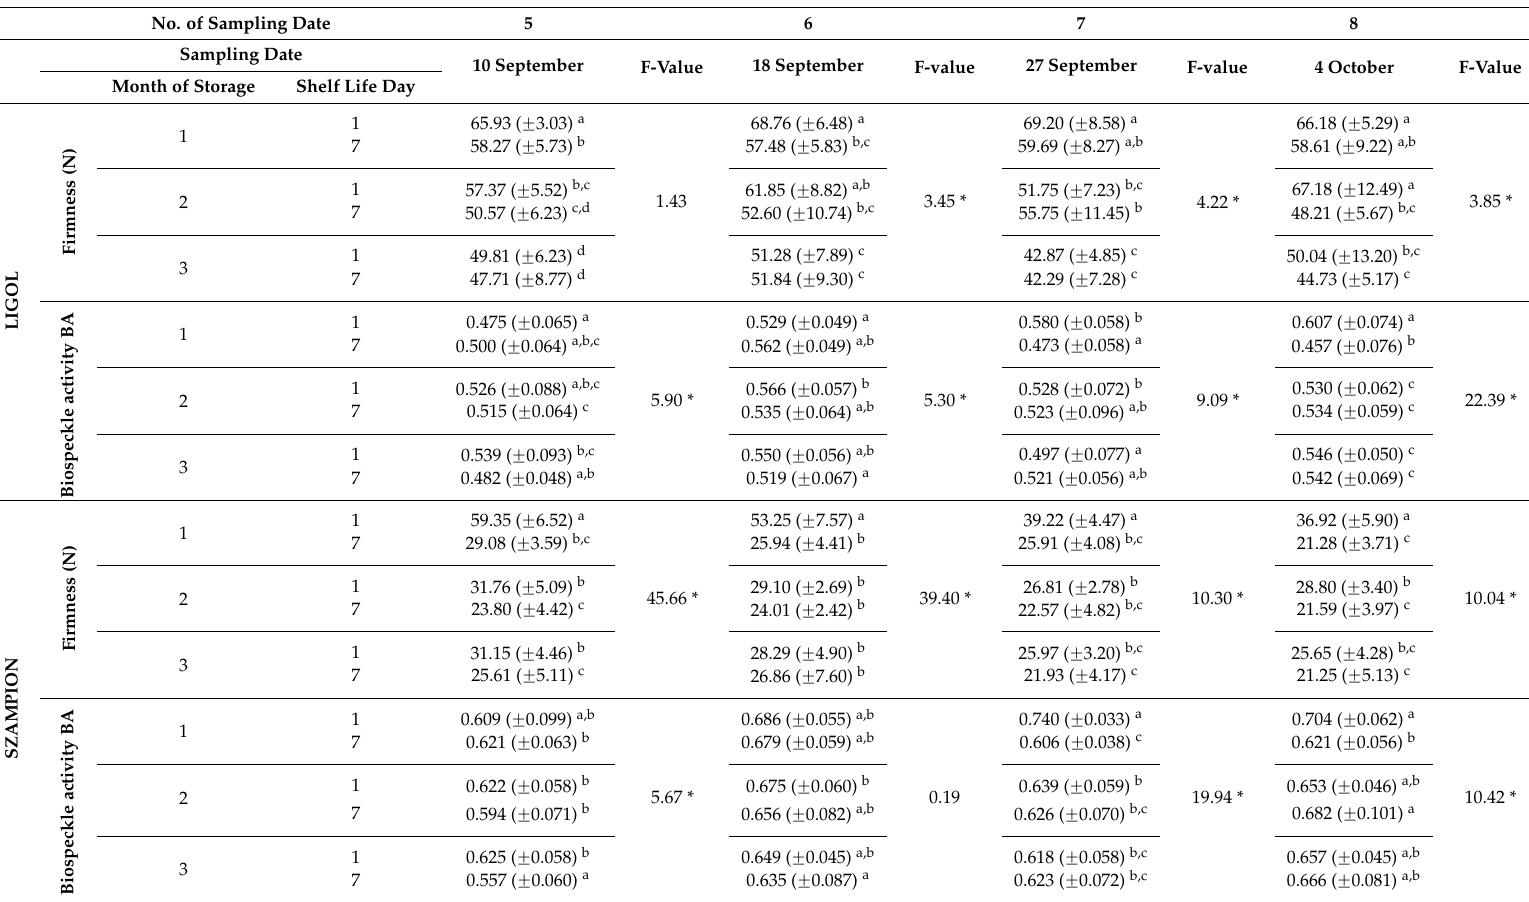
Table 2. Firmness and biospeckle activity of cv. “Ligol” and “Szampion” after one, two and three months of storage evaluated at the 1st and 7th day of shelf life. In parenthesis standard deviation. F-value of two-way ANOVA of month of storage*shelf life day